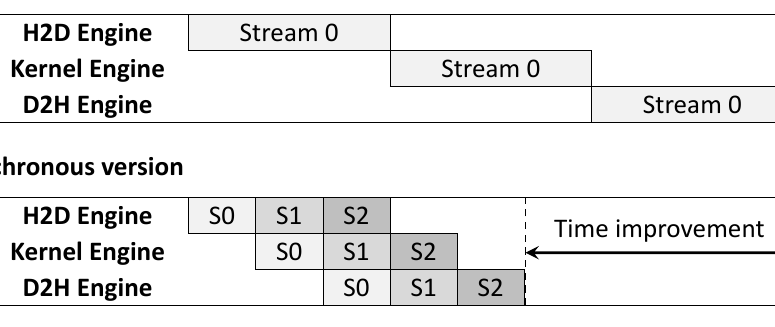
Figure 8. Asynchronous execution.